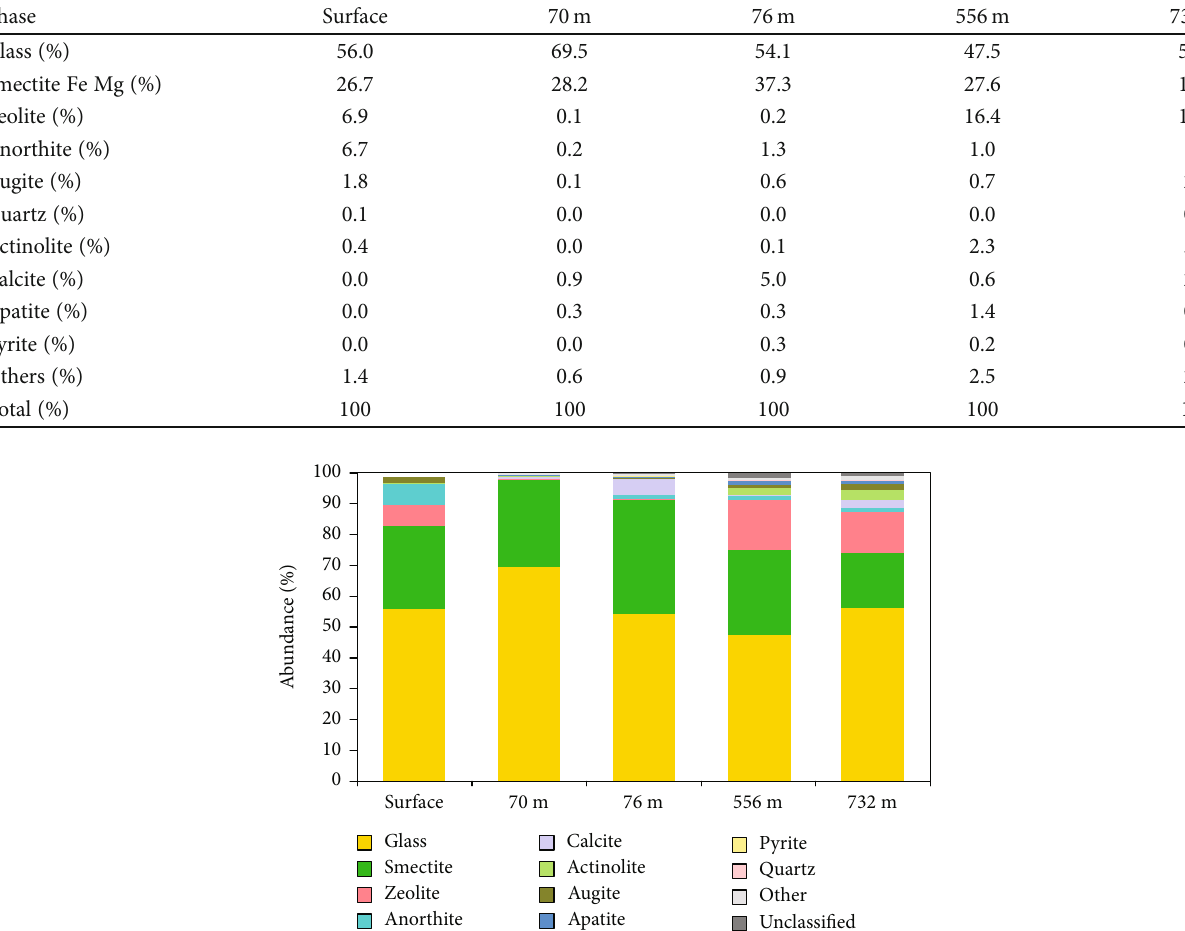
Table 2: SEM-EDS quantitative results, phase abundance of the solid fraction.